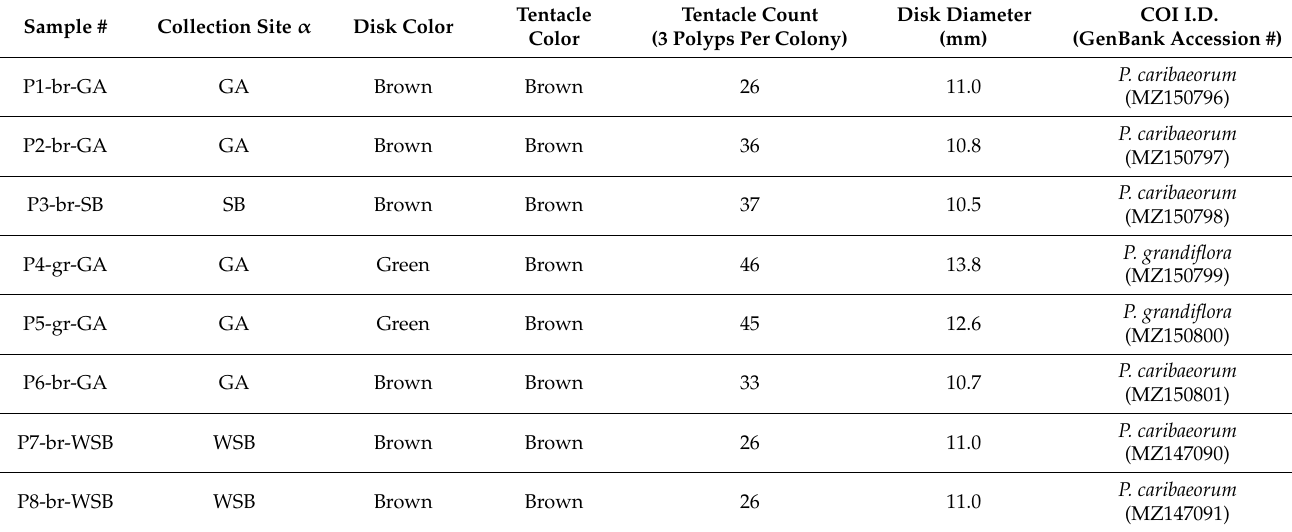
Table 1. Zoantharian specimens from the northeastern coast of Trinidad with collection information, morphological data, GenBank accession numbers, and identification conclusions based on COI